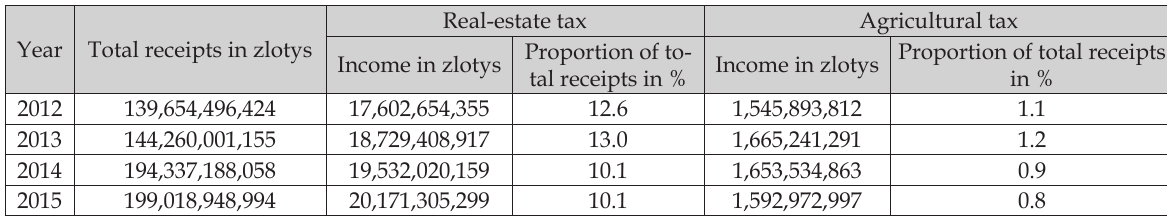
Source: own compilation on the basis of budgetary reports of local government units in the years 2012–2015, Ministry of